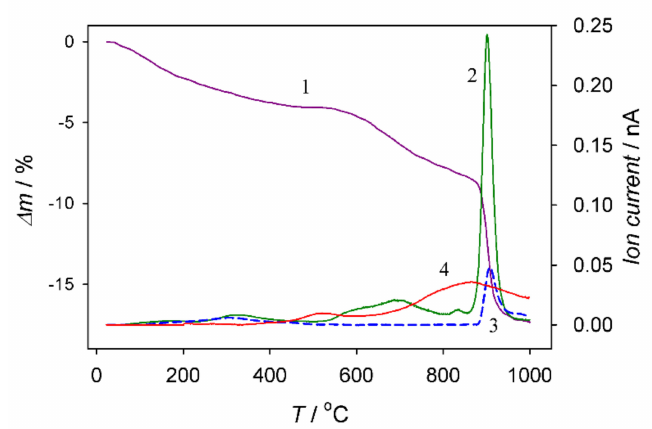
Figure 6. Variation of TG curve (1) and ionic currents of CO 2 (2) and CO species (3) during calcination of ~42 µ m thick aluminum anodic film in an argon atmosphere up to 1000 ◦ C and then in synthetic air up to 1000 ◦ C for the burning of remaining carbon to CO 2 (plot 4, × 10). The anodic film was formed at 80 V for 1 h as in Figure 3.